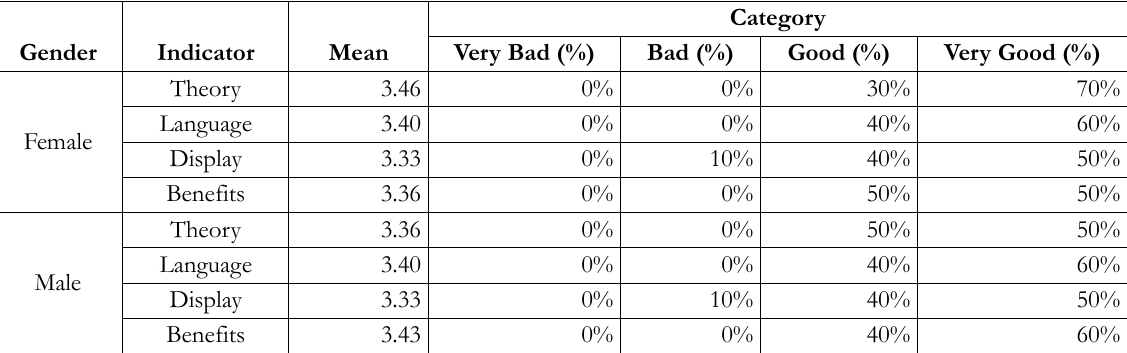
Table 8. Eighth Grade Student’s Perception of the Use of Web-based